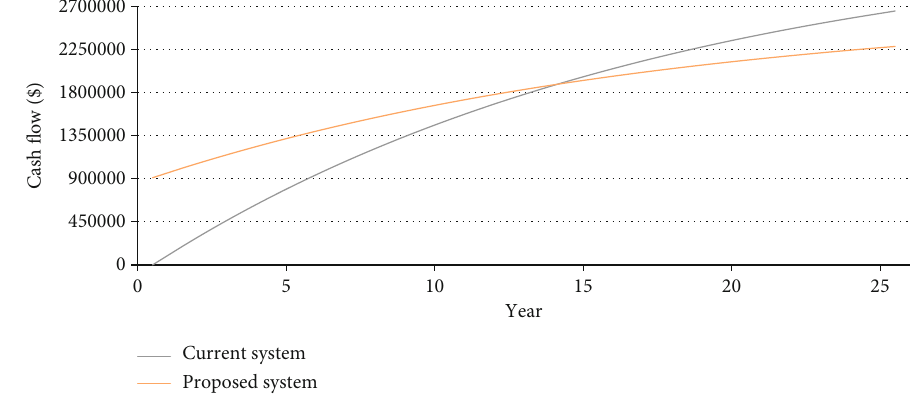
Figure 19: Cumulative cash fl ows over project lifetime for the current and proposed systems for